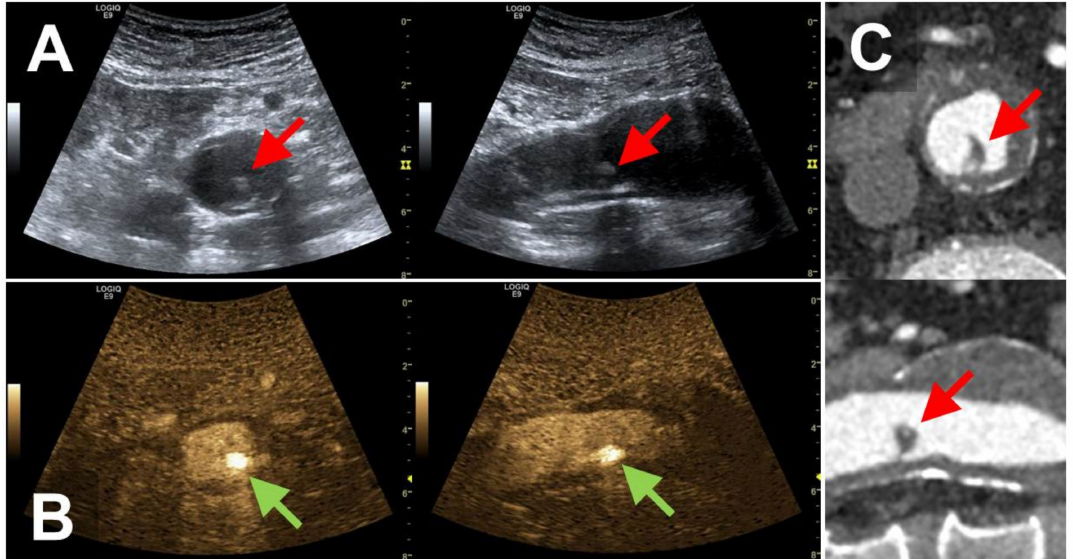
Figure 1. Transversal and longitudinal sections of a WAFAS (arrows) located in a small infrarenal aortic aneurysm displayed by B-mode sonography (panel A ), BFl (FLS, panel B ), and CTA (panel C ). WAFAS, wall-adherent, floating arterial structure; BFl, B-Flow; FLS, flashlight sign; CTA, computed tomography angiography.